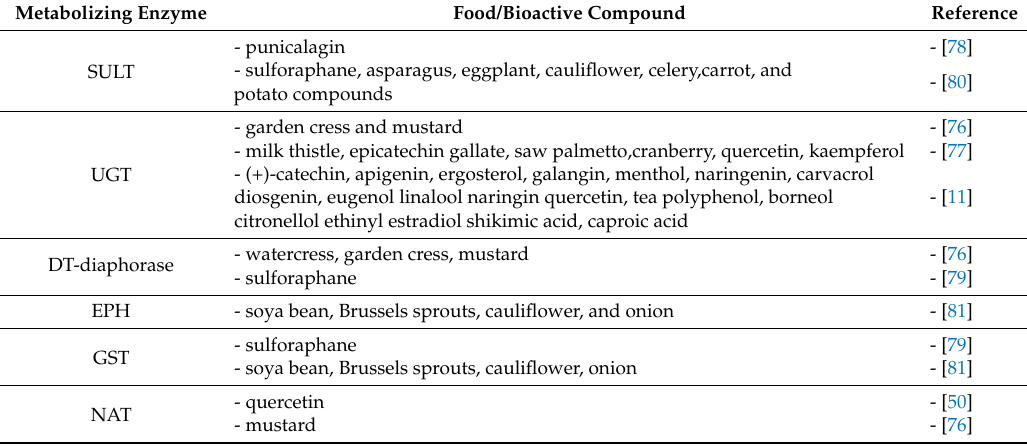
Table 4. Enteric and hepatic metabolizing enzymes of phase II that are targeted by foods or relative